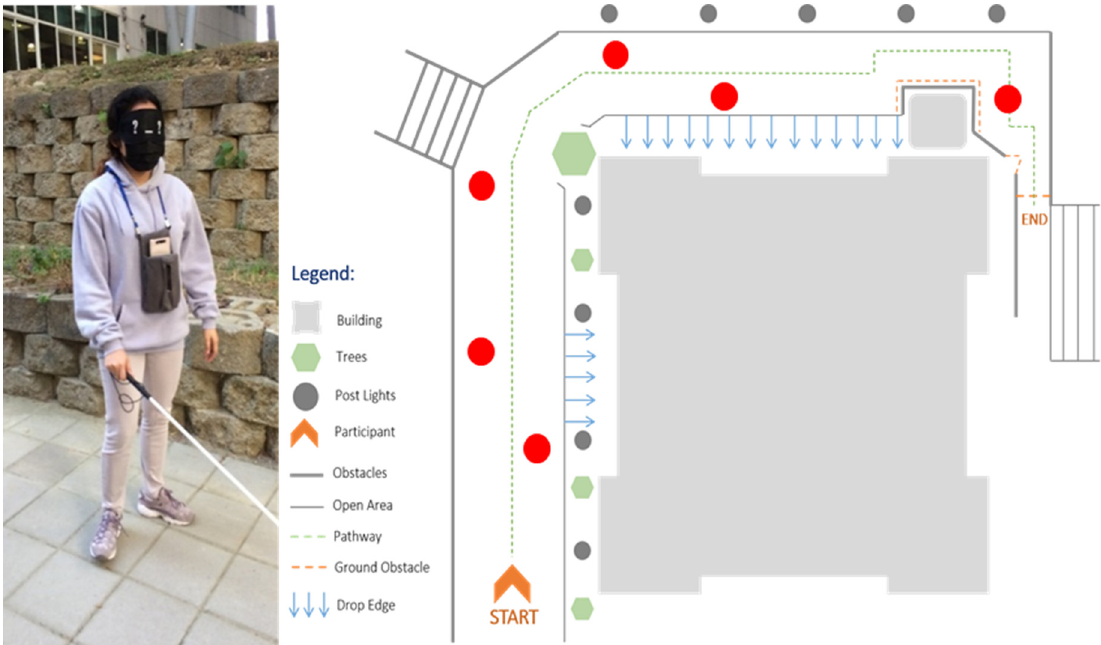
Figure 10. Blindfolded participant ( left ) with walking cane walking through the obstacle course ( right ) with randomly placed obstacles along the way.